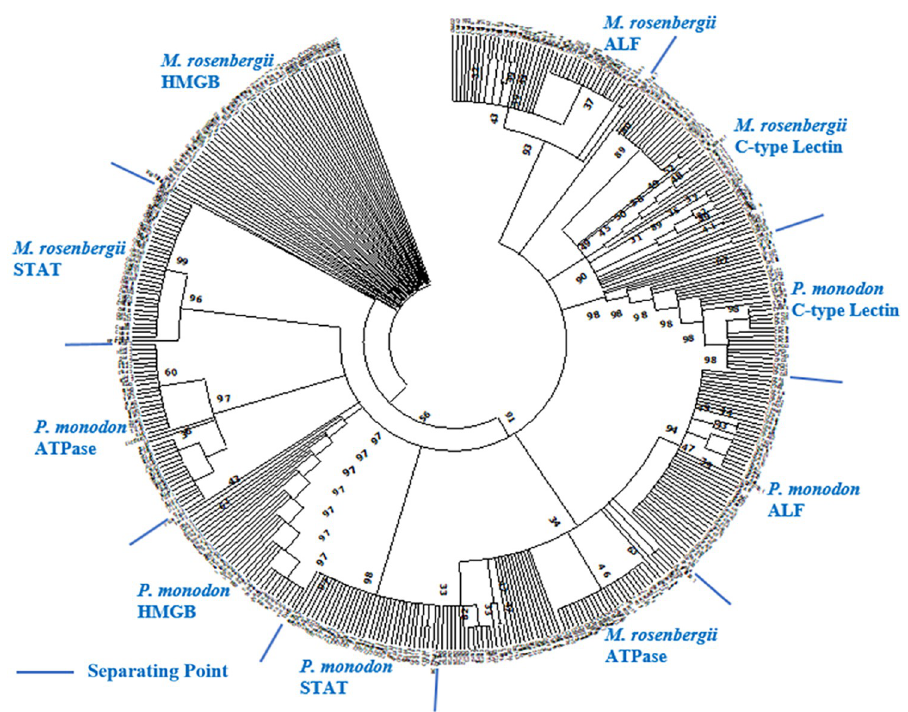
Fig 3. Maximum likelihood-based phylogenetic analysis generated using MEGA X software (Bootstrap: 1000) for total cDNA sequences. Sample groups: M . rosenbergii and P . monodon . Genes: C-type Lectin, HMGB, STAT, ALF3 (ALF), and ATPase 8/6